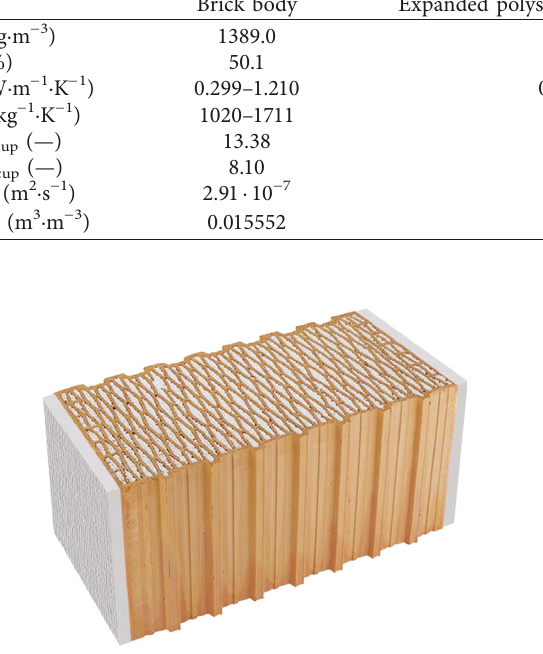
Figure 1: The ceramic block filled with polystyrene with plaster indicated (width � 247mm, length � 500mm, and height � 250mm).